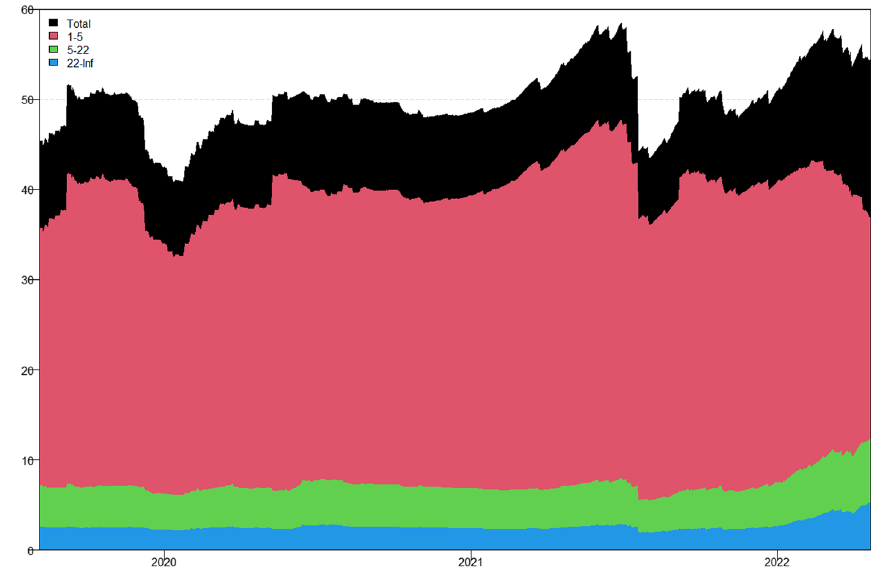
Fig. 34 Dynamic total RK connectedness—robustness check